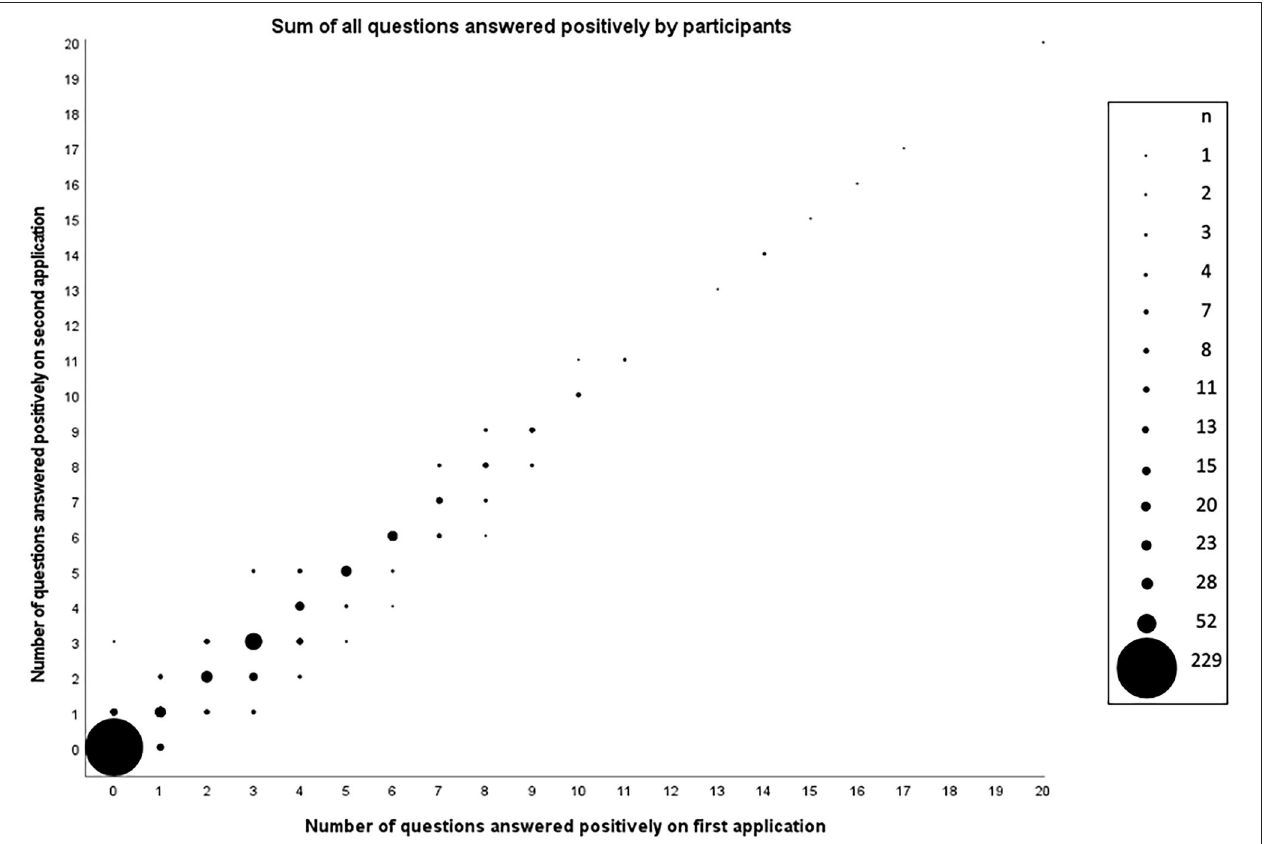
FIGURE 1 | Number of questions answered positively by participants ( n = 493) in the first and second applications of the Brazilian Portuguese version of the PAR-Q +